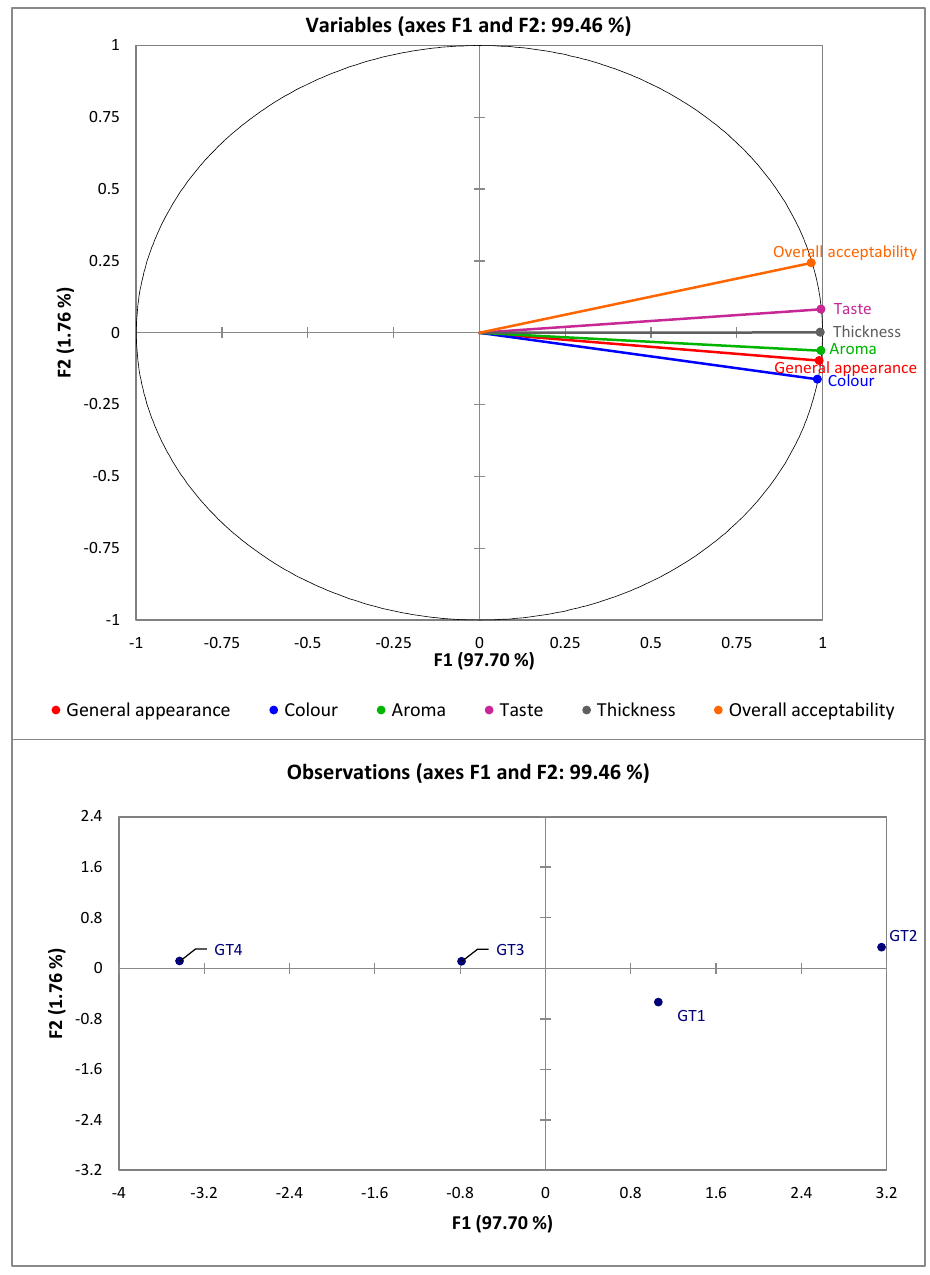
Figure 2. The map/plot showing the correlation between sensory properties of porridges from OFSP-based composite